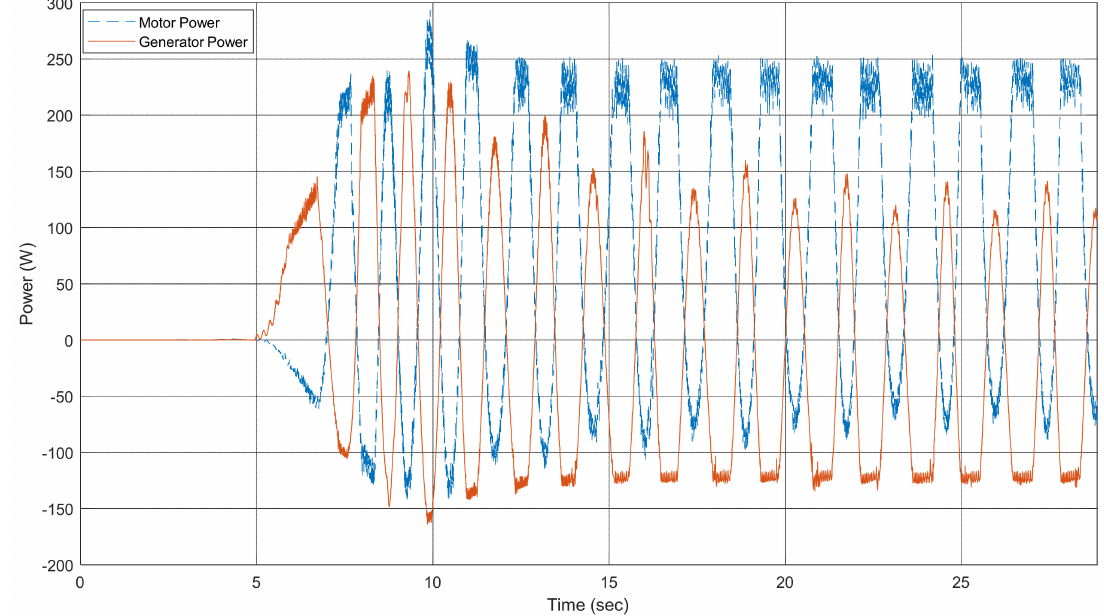
Figure 10. Motor and generator powers for the regular wave case presented in Figure 7a (i.e., crank radius is 2